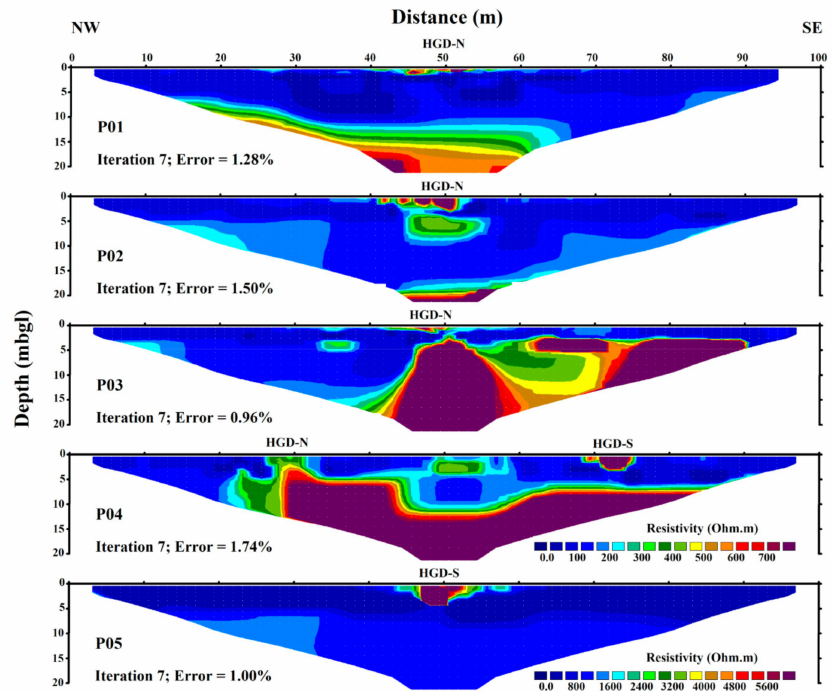
Figure 7. Modeled resistivity sections across the HGD-N and HGD-S outcrops. The legend for profiles P01–P04 is located in profile P04. Due to the much higher resistivities recorded along profile P05, a different color scale is used for the resistivity model of this profile. mgbl: meters below ground level.